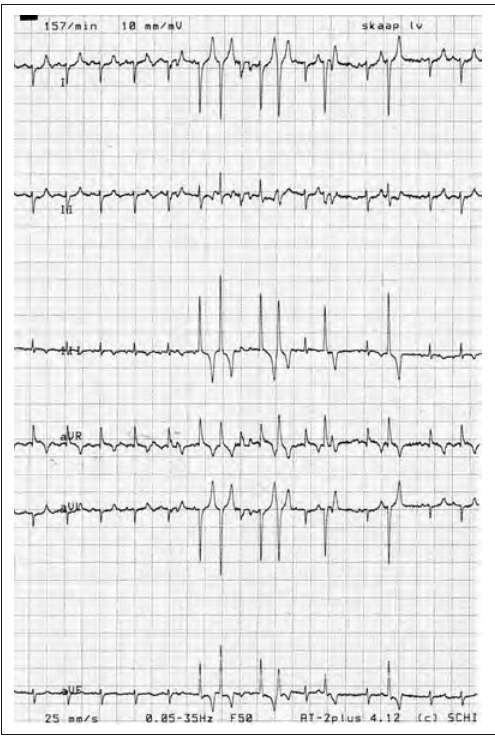
FIG. 3 The 12-lead electrocardiogram, demonstrating the appearance of PVCs in Leads I, II, III, aVR, aVL and